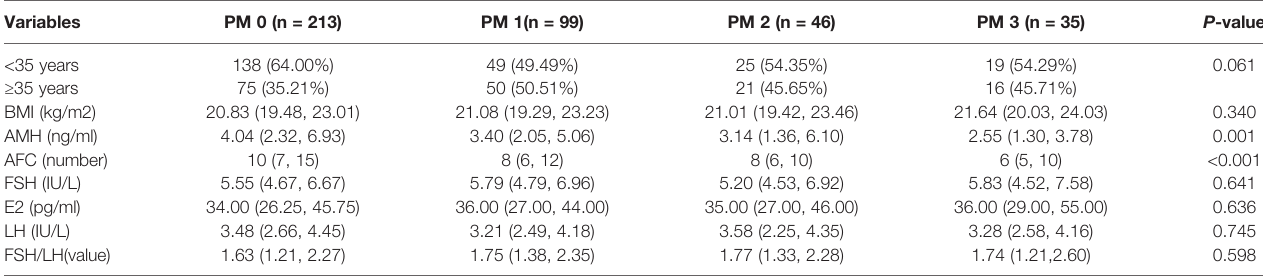
TABLE 1 | Comparison of baseline characteristics and parameters of the ovarian reserve between